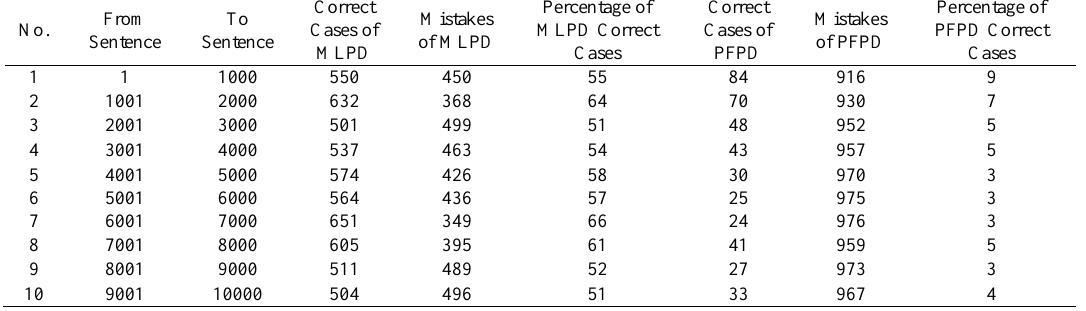
Table 3. Results of comparison made between each sentence and google translation